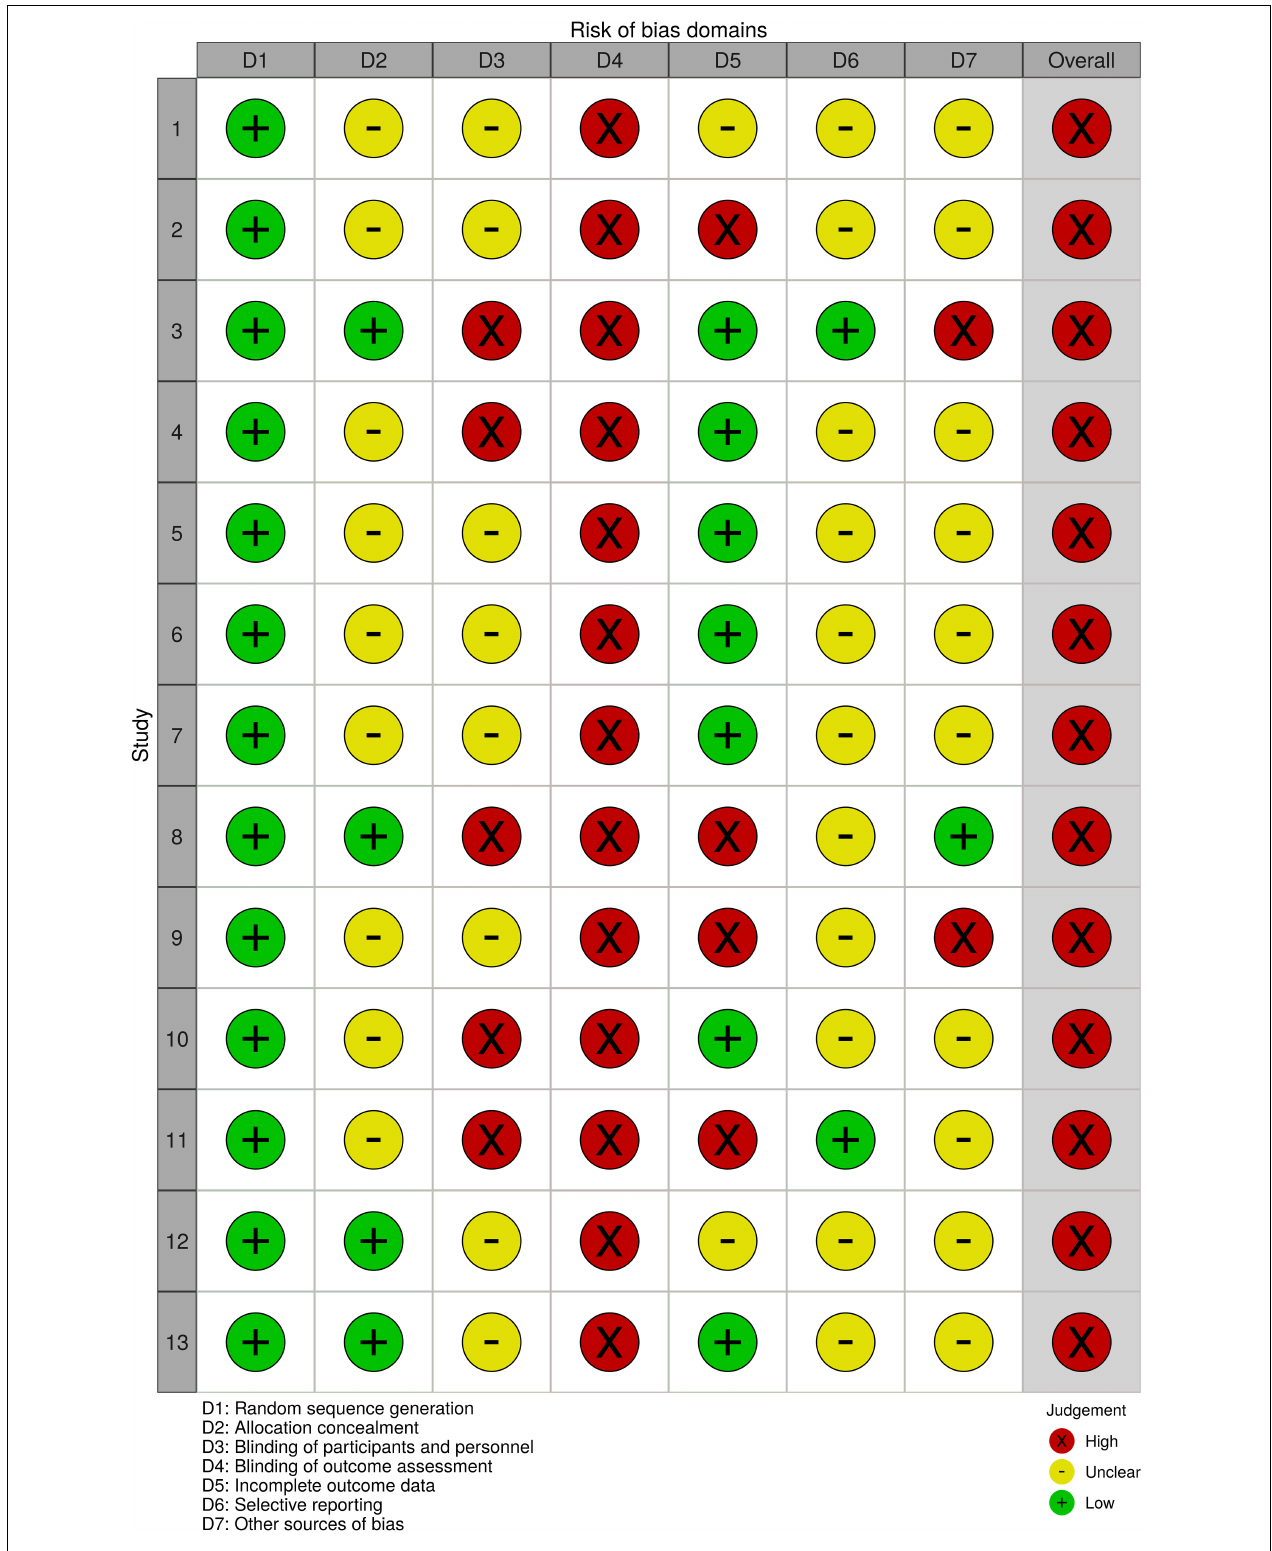
FIGURE 4 | Risk of bias for each